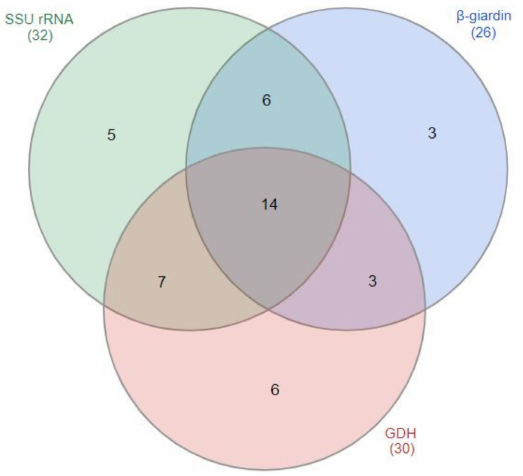
Figure 2. Venn diagram of Giardia-duodenalis -positive samples ( n = 44). Numbers of fecal samples that were PCR positive for ssu rRNA gene and/or bg gene and/or gdh gene are provided. Table 2. Nucleotide variations among the 26 β -giardin sequences detected from the feces of 792 calves. Nucleotides at Variable Positions Accession No. 1 45 150 252 393 MW876414, 15, 17, 19, 20, 24–27, 30, 34, 35